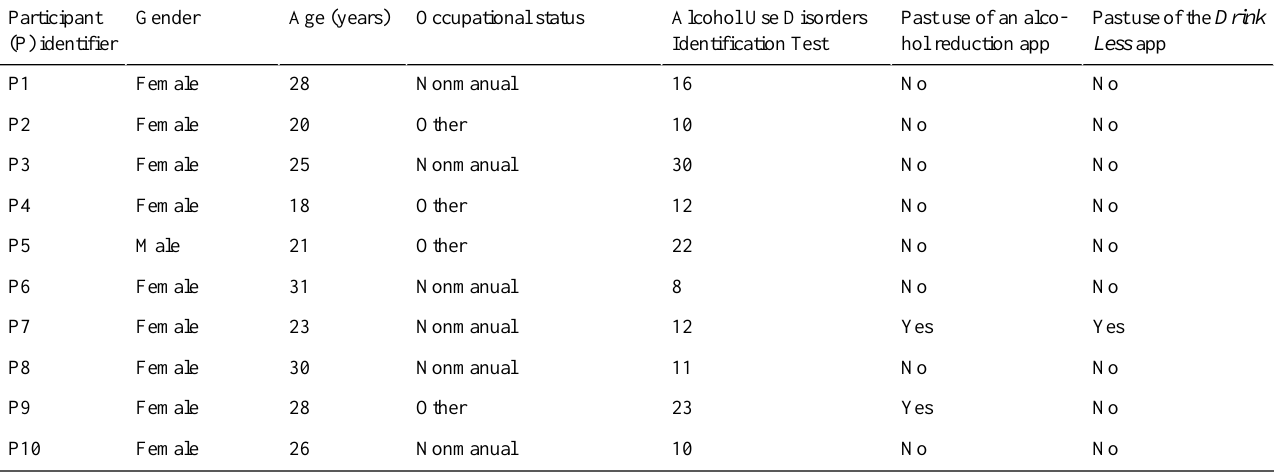
Table 2. Participants’demographic, drinking, and app-related characteristics.